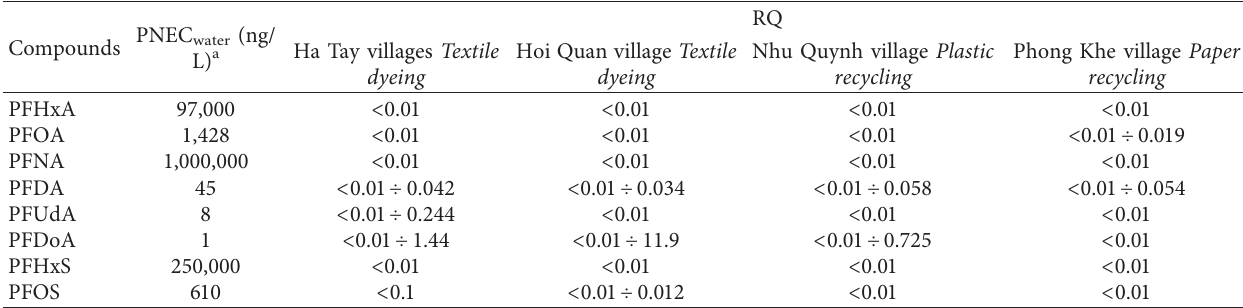
Table 5: Risk quotients of eight target